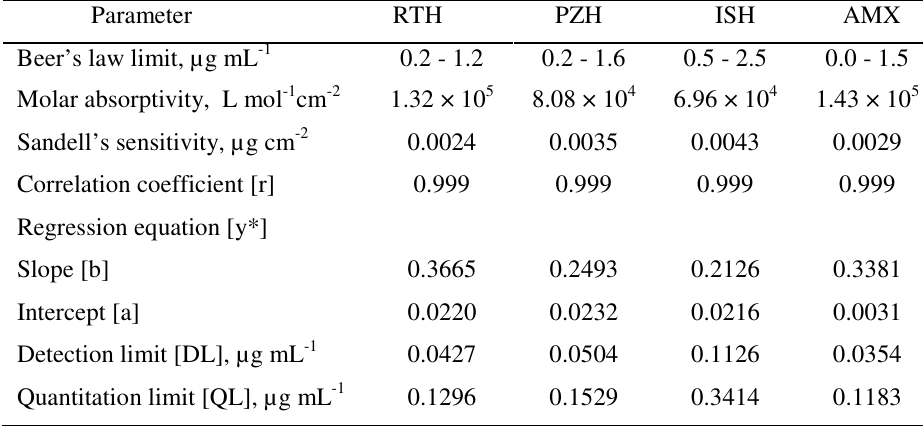
Table 2. Optical characteristics and precision